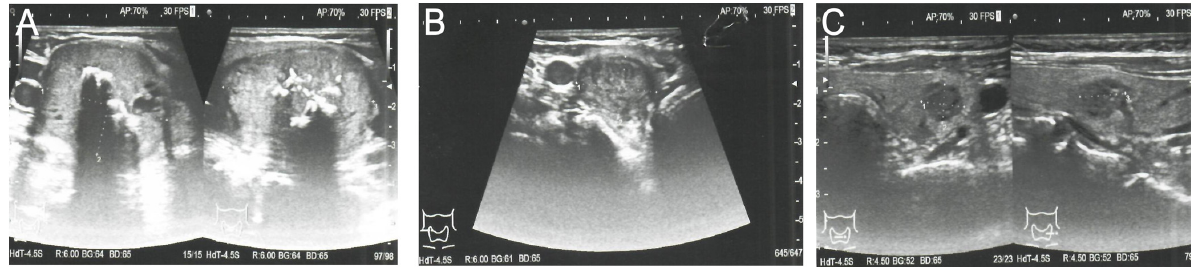
Figure 2. Preoperative ultrasound of the thyroid gland and the EU-TIRADS categories of thyroid nodules. ( A ) Right lobe, showing the dominant thyroid nodule, measuring 35 × 29 × 41 mm, with macrocalcifications; EU-TIRADS 4. ( B ) Right lobe, showing a second hypoechogenic nodule 22 mm in width and 16 mm in height; EU-TIRADS 4. ( C ) Left lobe, showing a hypoechogenic nodule, measuring 9 × 7 × 9 mm, with irregular margins; EU-TIRADS 5.